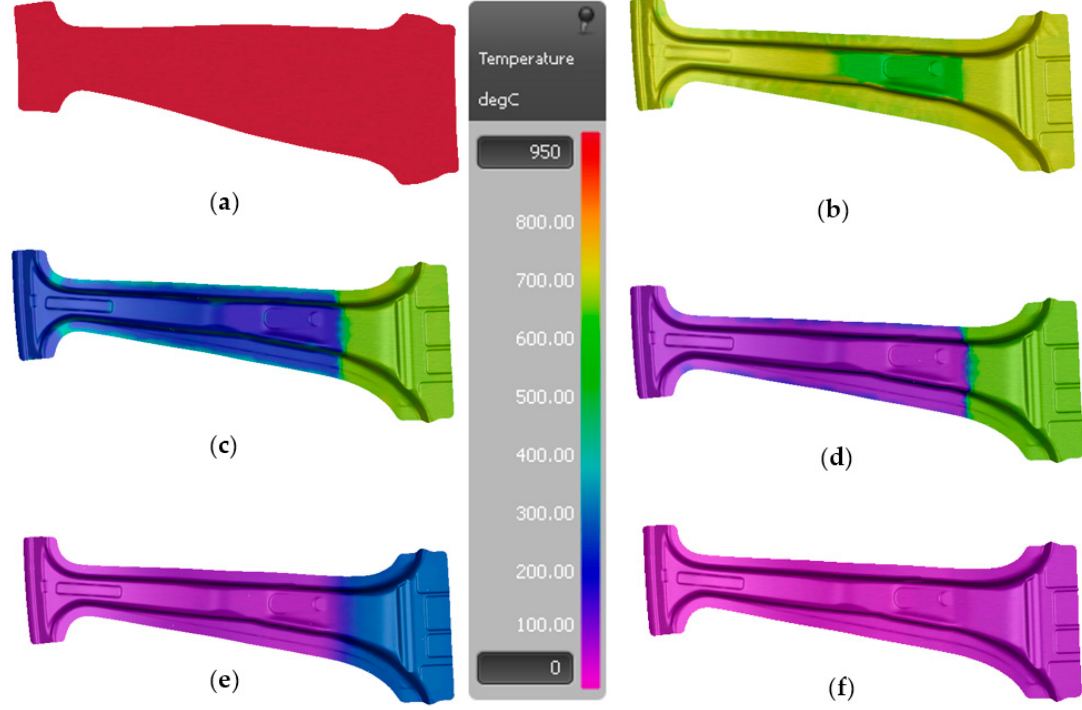
Figure 11. The change in temperature during the partition cooling in hot stamping: ( a ) before stamping; ( b ) stamping for 3 s; ( c ) stamping for 5 s; ( d ) stamping completed; ( e ) cooling; and ( f ) cooled.